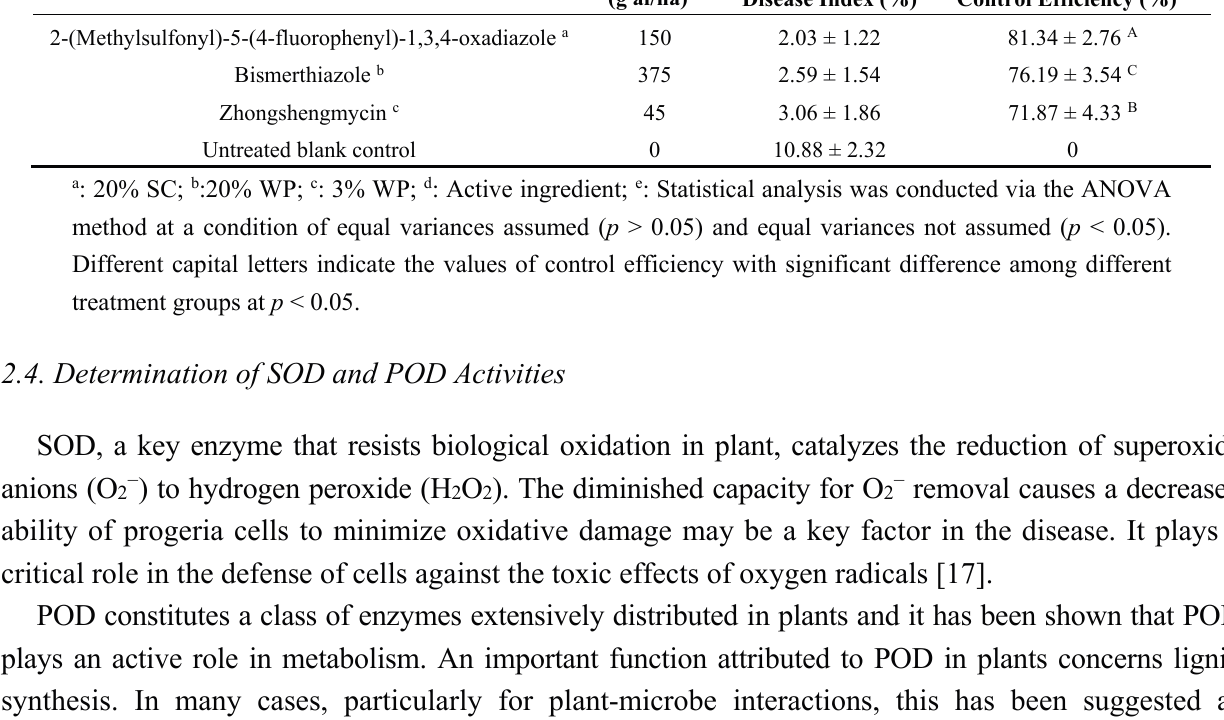
15 Days after the Third Spraying Dosage (g ai/ha) d Disease Index (%) Control Efficiency (%)